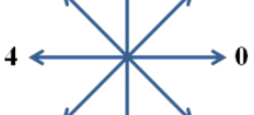
Figure 6. An example of deleting isolated points using chain codes. ( a ) The input. The pink grid is the start pixel of chain code tracing. ( b ) An erosion result of ( a ). ( c ) A dilation result of ( b ). Figure 7. An illustration of chain codes. ( a ) The eight directions given by Freeman chain codes [28]. ( b ) The new eight directions used in this study.